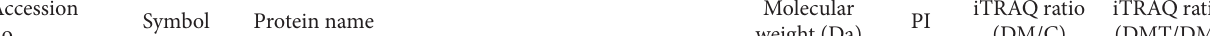
Table 1: Functional classification of altered proteins related to cardiac lipid metabolism, mitochondrial function, and cardiomyopathy. Accession